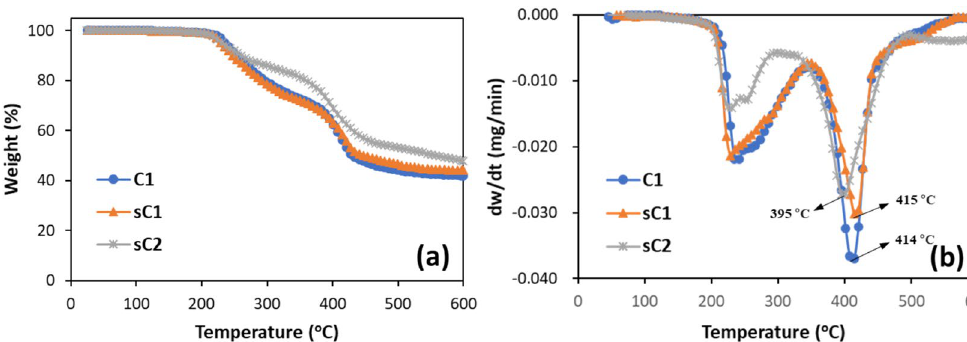
Figure 8. TG–DTG curves of Case III